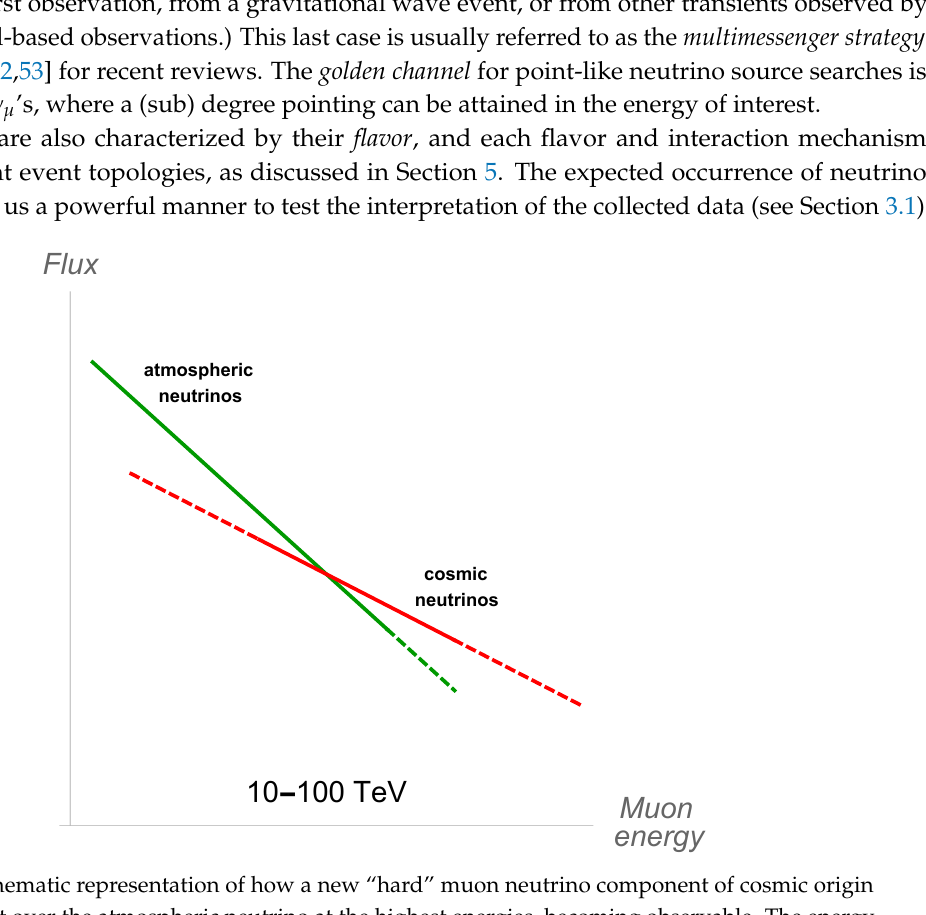
Figure 4. Schematic representation of how a new “hard” muon neutrino component of cosmic origin can stand out over the atmospheric neutrino at the highest energies, becoming observable. The energy regions where the uncertainties are larger are represented with dashed lines. For atmospheric neutrinos the uncertainty is due to the precise shape of the cosmic ray knee and the amount of prompt neutrinos; for cosmic neutrinos it is due to the production mechanism—moreover at low energies it is difficult to isolate them, while at high energies events are